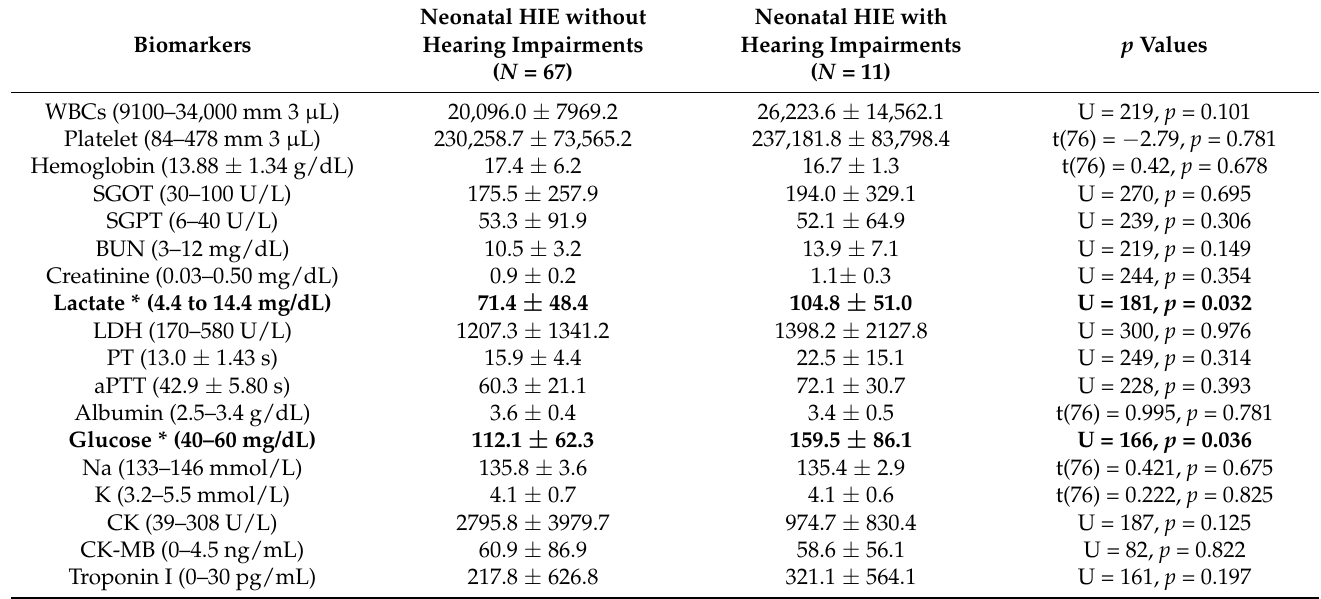
Table 2. Biomarkers of 78 patients with neonatal HIE with and without